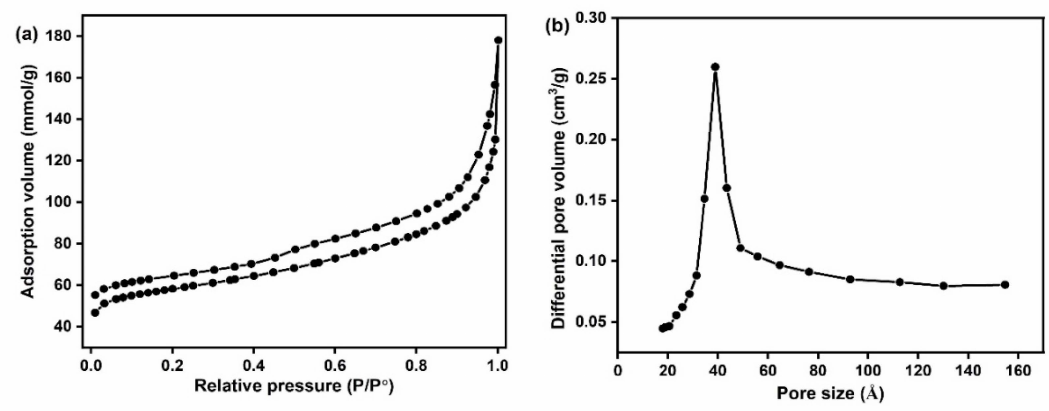
Figure 6. N 2 physisorption isotherms ( a ) and pore size distributions ( b ) of the OMSC